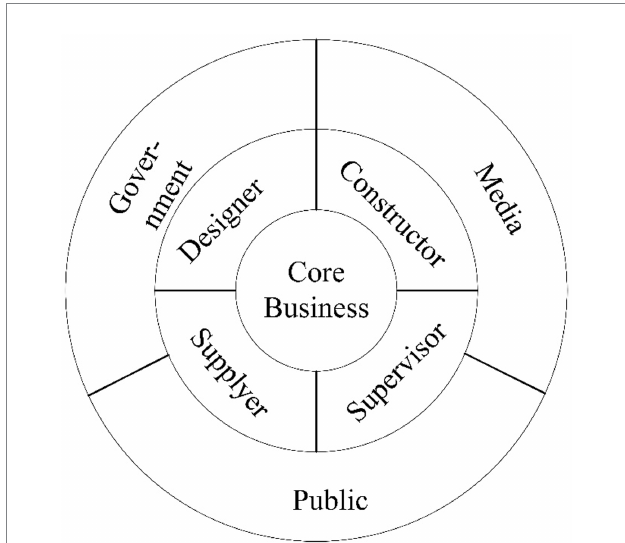
FIGURE 2 “Engineering Community” system.